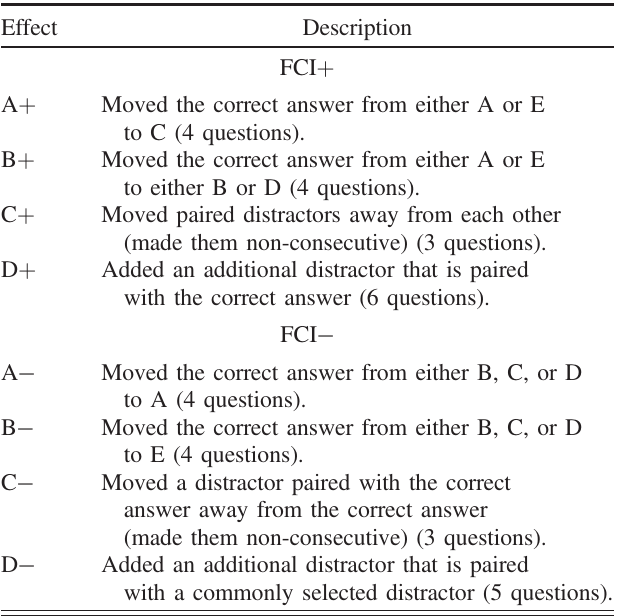
TABLE VII. Description of changes to FCI þ and FCI- instruments in data set 4.